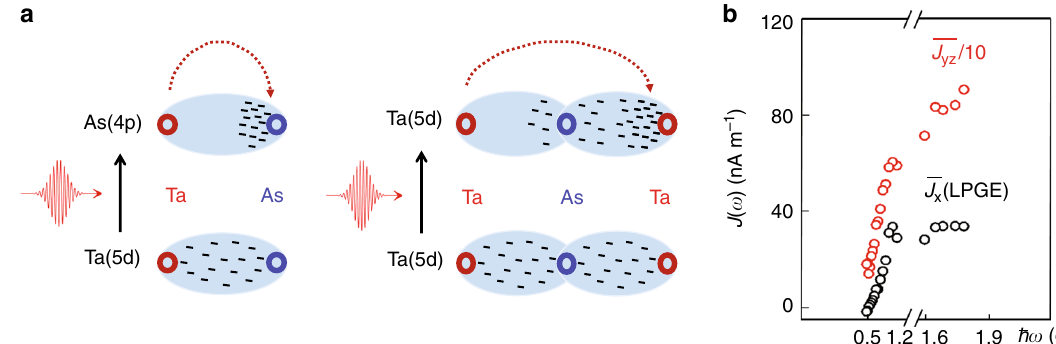
Fig. 8 Schematic of LPGE and its dependence on the incident photon energy. a Owing to the initial states being dominated by Ta 5 d orbitals and the fi nal states contributed by both Ta 5 d and As 4 p orbitals 17 , the shift current is attributed to the ultrafast transfer of electron density along both the Ta-As and Ta-(As)-Ta bonds. b Experimental DC sheet current densities, J thermal effects,